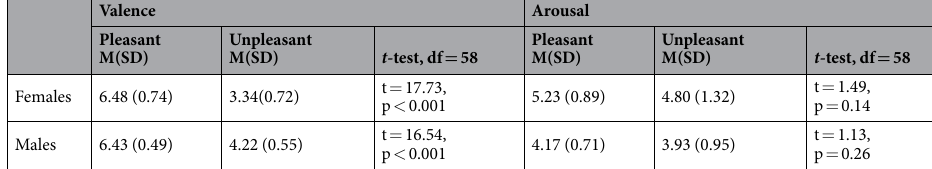
Table 2. Valence and arousal of the stimuli used in the experimental